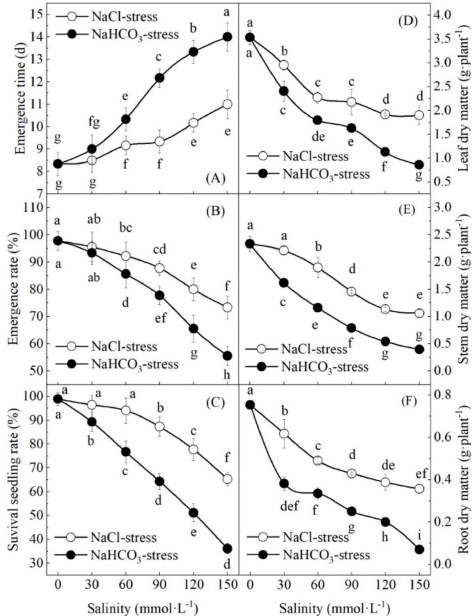
Figure 1. E ff ects of NaCl and NaHCO 3 stresses on seedling emergence time ( A ), emergence rate ( B ) and survival rate ( C ), dry mass of leaves ( D ), stems ( E ), and roots ( F ) of the common bean ( Phaseolus vulgaris ). Common beans were treated with NaCl (30–150 mmol · L − 1 , pH 6.65–6.86) and NaHCO 3 (30–150 mmol · L − 1 , pH 8.17–8.27) stresses. Data points and bars represent the mean ± SD of